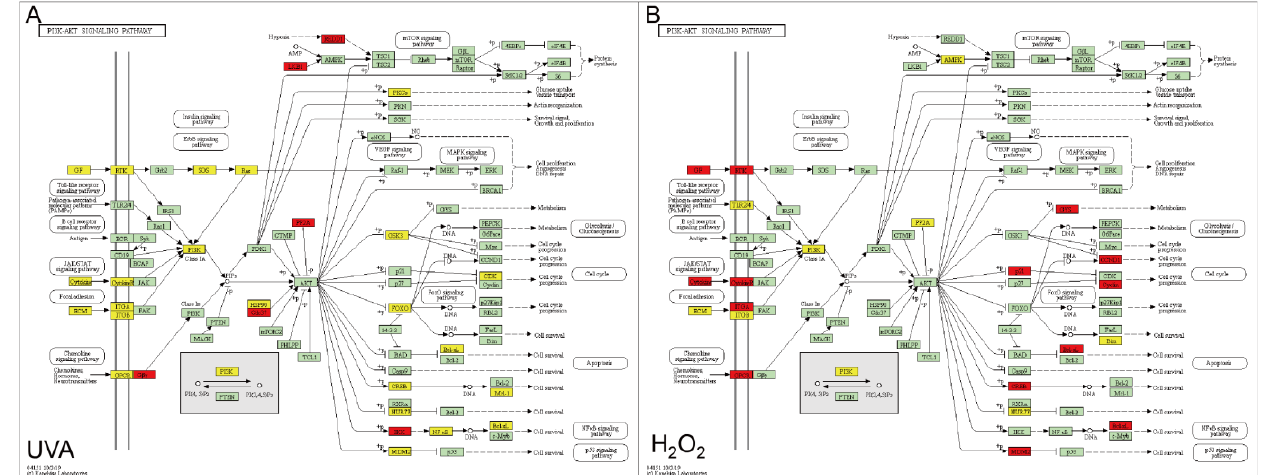
Figure 3. PI3K-AKT Signaling Pathway in UVA-induced( A ) and H 2 O 2 -induced( B ) model. Red: upregulated gene; Yellow: downregulated gene; Green: not regulated significantly gene.